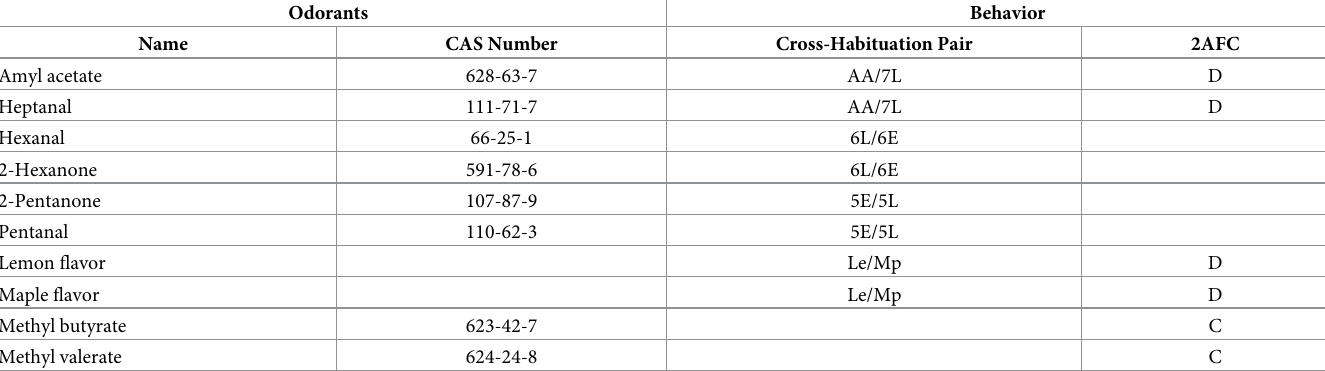
Table 1. List of odorants. Odorants utilized in behavioral experiments along with their CAS numbers. The four odorant pairs used for cross-habituation studies (at 70:30 vs 30:70 mixture ratios; Fig 8B) are identified with descriptive labels. Odorant pairs used in two-alternative forced choice tests (2AFC; Fig 8C and 8D) are identified with their panel